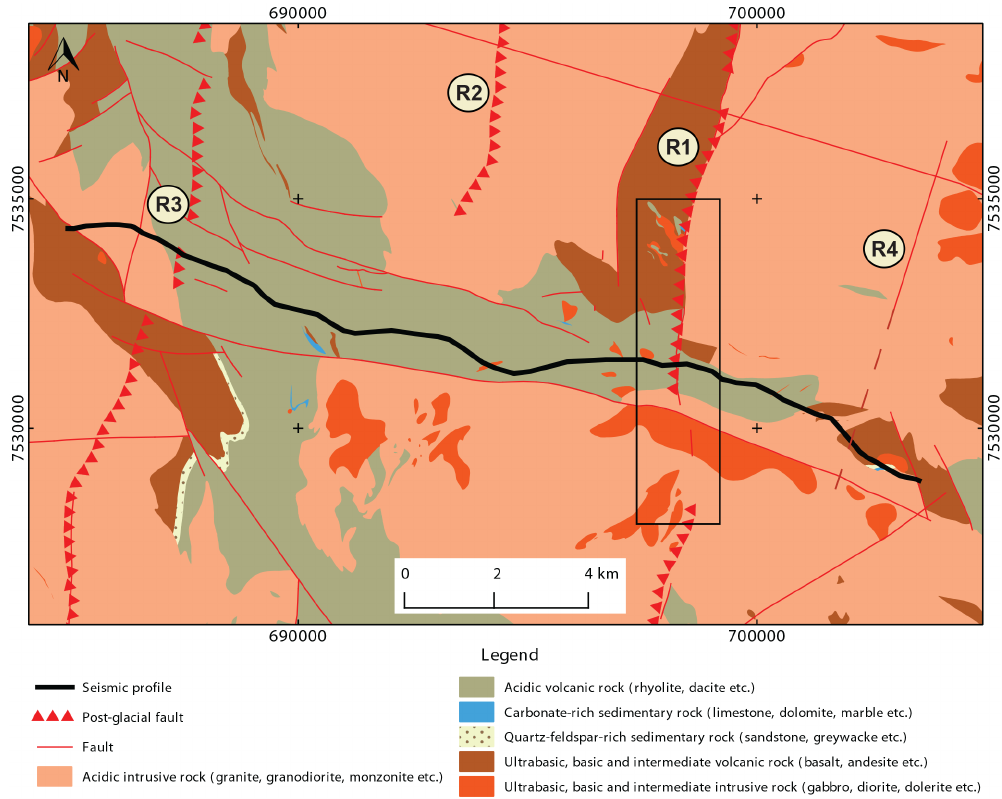
Figure 8. The bedrock geological map of the area based on Geological Survey of Sweden (SGU) database. The rectangle shows where the ultramafic rocks are exposed around the strongly reflective fault R1 (see Fig.